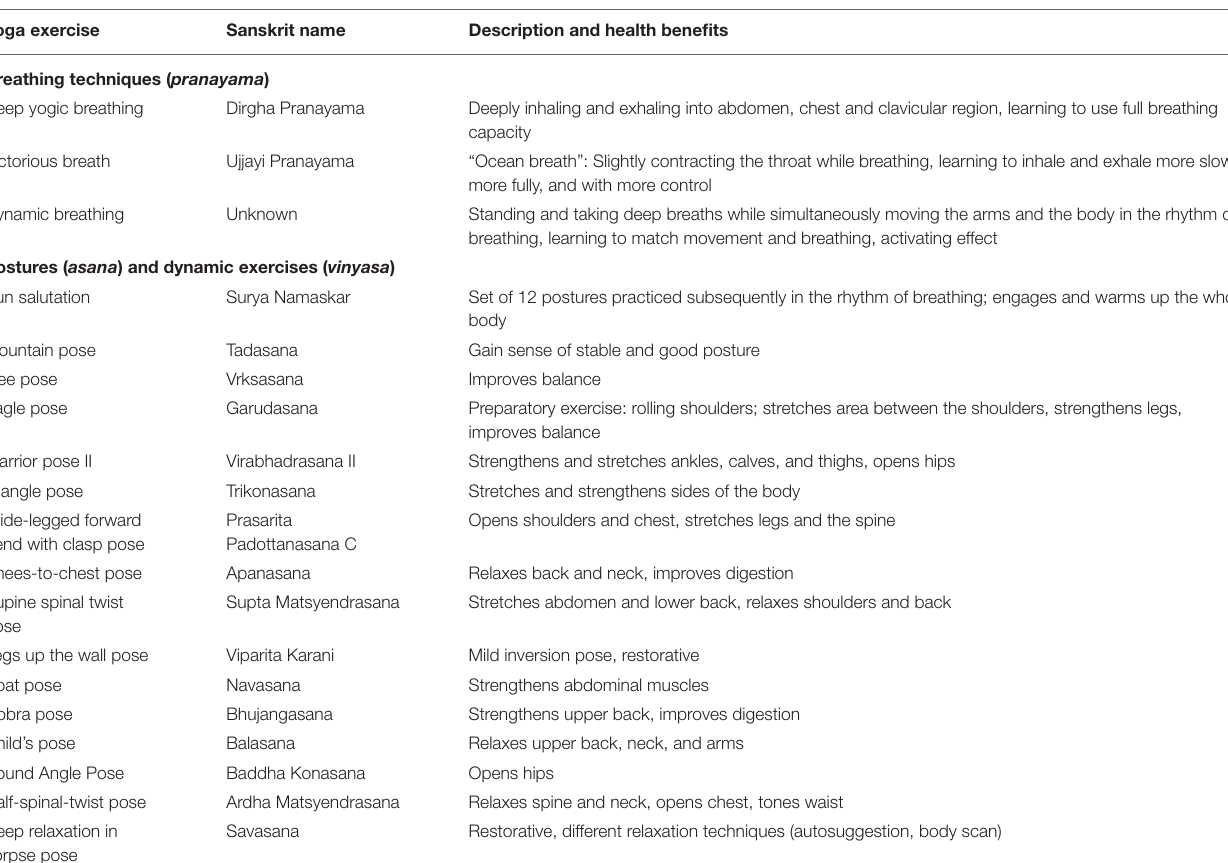
TABLE 2 | Set of physical yoga and breathing exercises taught in the physical yoga component including their sanskrit names, short descriptions, and proposed health benefits. Yoga exercise Sanskrit